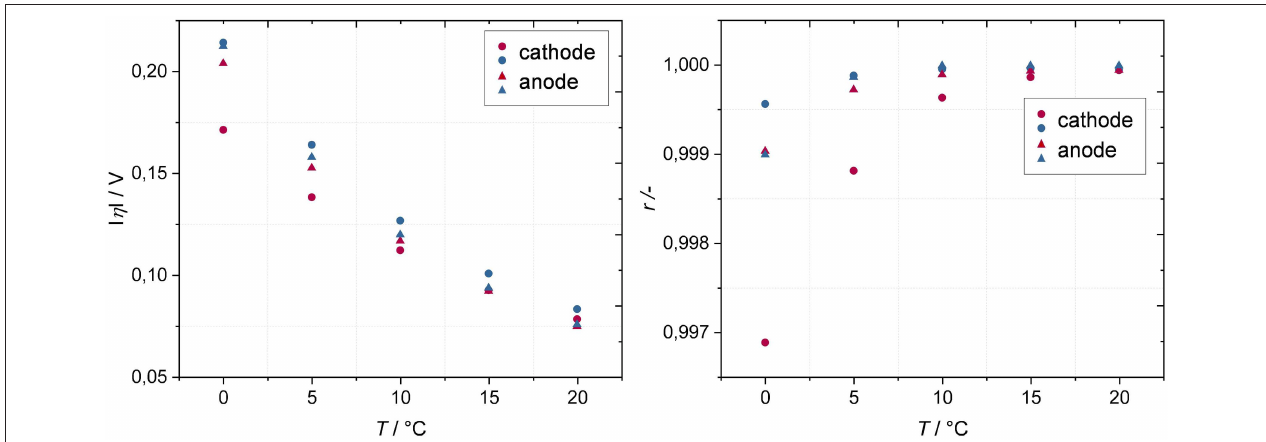
FIGURE 9 | Overpotentials based on a DC bias of 5mA (Left) and corresponding correlation coefficients based on a DC bias range of 1–5mA ( 1 I = 1mA) (Right) of cathode and anode in charge (red) and discharge (blue) direction as a function of temperature at a cell voltage of 3.7 ◦ V.